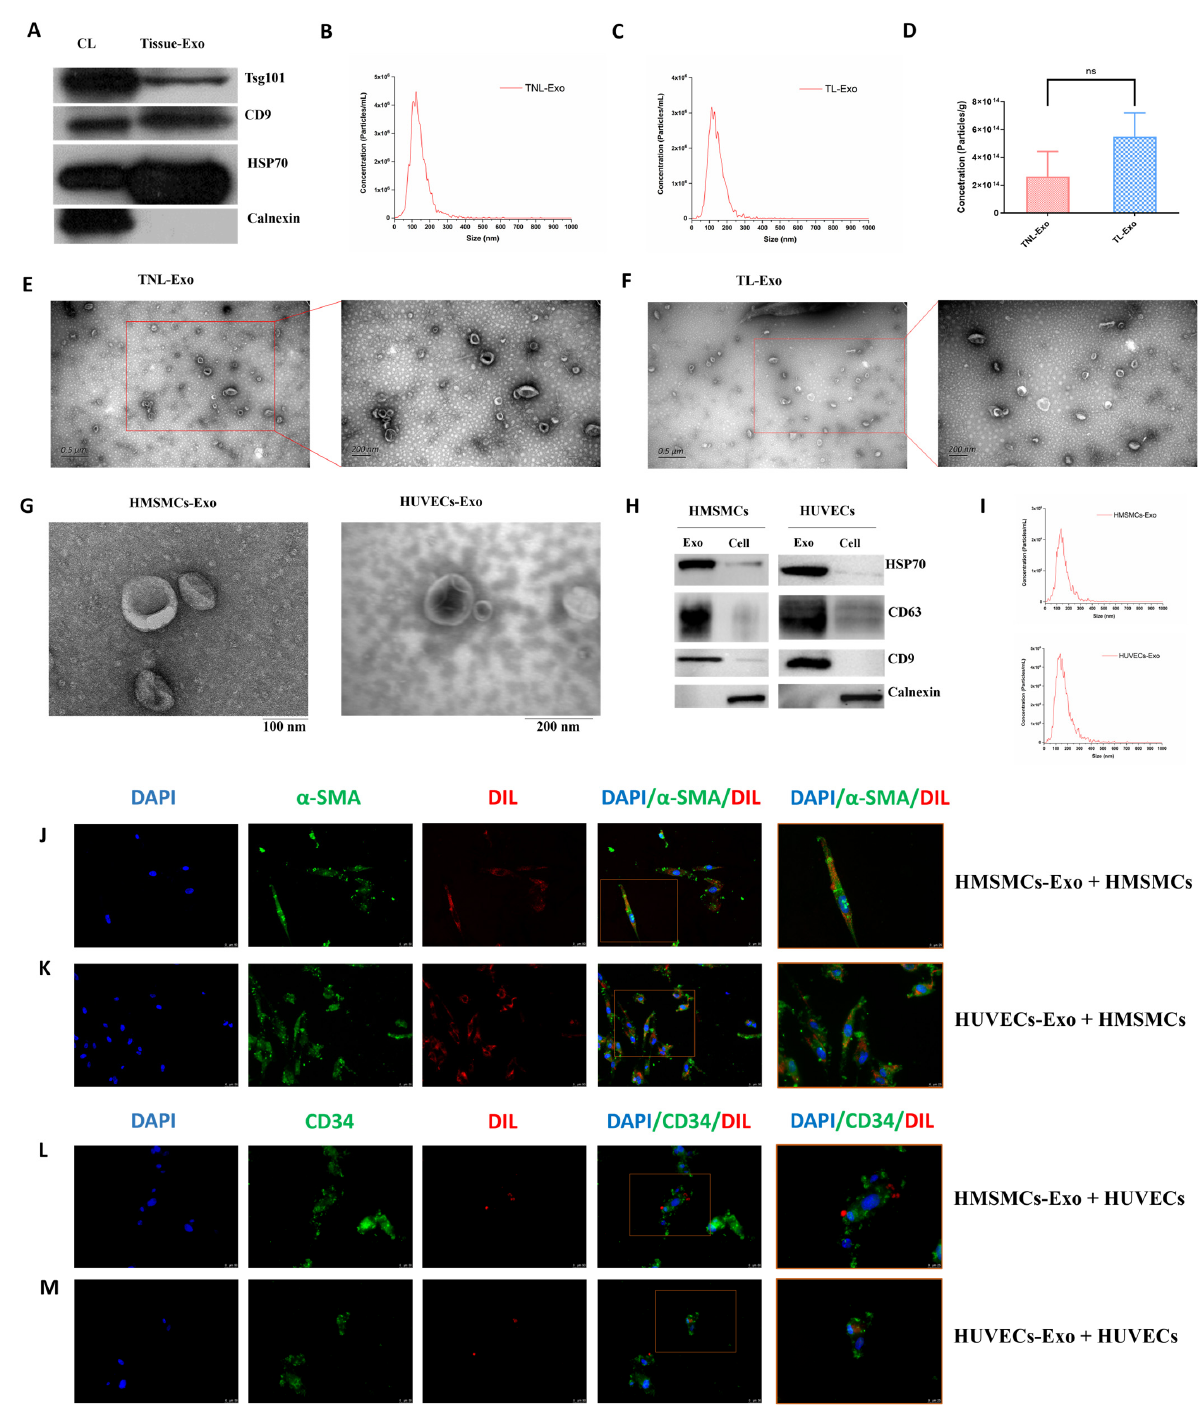
Figure 1. Characterization of exosomes isolated from myometrial tissue, HMSMCs and HUVECs. ( A ) Western blotting for Tsg101, CD9, HSP70, and Calnexin in cell lysis (CL) and myometrial tissue exosomes (Tissue-Exo). ( B , C ) Nanoparticle tracking analysis (NTA) measurements showing the size distribution of exosomes in term non-labor (TNL) and term labor (TL) myometrial exosomes. ( D ) Concentrations of exosomes derived from TNL and TL myometrial tissues had no significantly difference ( p > 0.05). ( E – G ) TEM showing round/cup-shaped exosomes in the myometrial, HMSMC, and HUVEC exosomes. ( H ) Western blotting for HSP70, CD63, CD9, and Calnexin in the HMSMC and HUVEC exosomes. ( I ) NTA showing the size distribution of HMSMC and HUVEC exosomes. ( J – M ) Absorbing of Dil-labelled HMSMC and HUVEC exosomes inside the cells. DAPI was used to stain nuclear and α -SMA/CD34 were used to stain HMSMCs/HUVECs, respectively. Exo, exosomes. ns, not